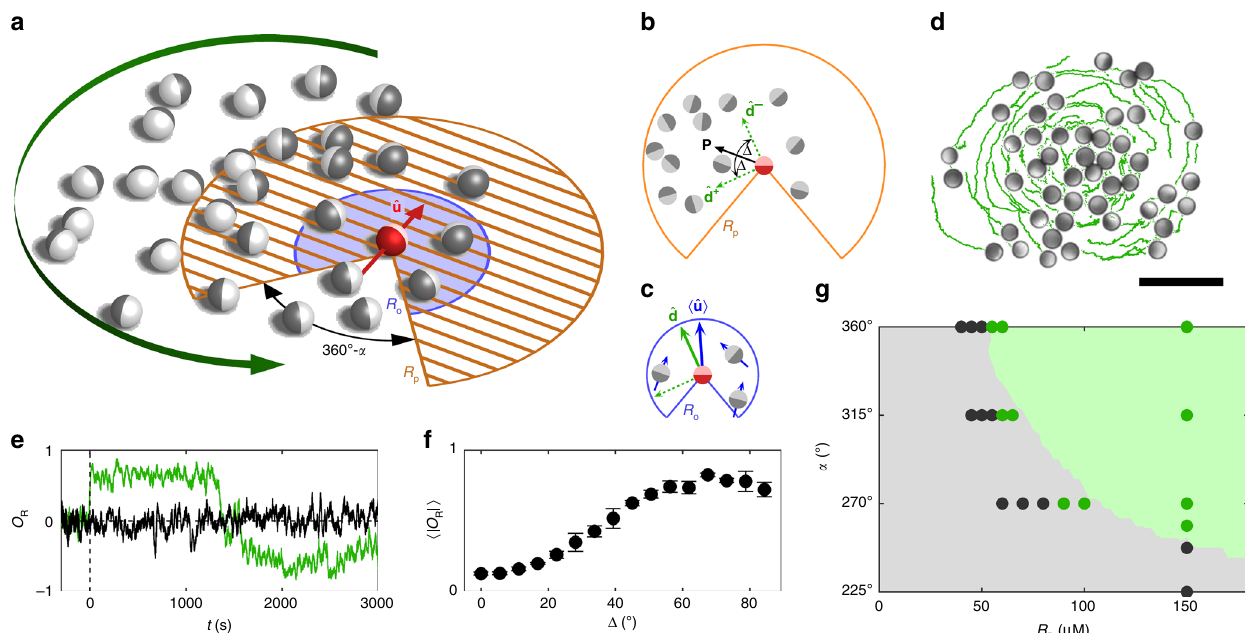
Fig. 1 Swirl formation of socially interacting active particles. a Illustration of interaction rule leading to circular group motion. An AP (red) senses the positions and orientations of neighbours within its fi eld of vision with angle α and range R p (orange dashed region and b ) and R o (blue region and c ), respectively. b After having determined the direction P to the centre of mass of sensed particles within distance R p , the AP selects one of two possible þ (cid:3) swimming directions ^ d or ^ d (green arrows) that deviate by the angle Δ to the left or the right relative to P . c The selection of the swimming direction ^ d depends on which of the two possibilities is closer to the mean orientation ^ u h i of neighbours being closer than R o . d Experimental snapshot of a counterclockwise rotating swirl for α = 360°, Δ = 67.5° and R p = ∞ . The solid lines show trajectories of 150 s. Scale bar is 30 μ m. e Time evolution of the j jh i as a function of the deviation angle Δ . Error bars correspond to the rotational order parameter O R for Δ = 67.5° (green) and Δ = 0 (black). f O R standard deviation of different experiments. g Existence range of cohesive swirls (green) as a function of α and R p determined from experiments (symbols) and numerical simulations (coloured areas) for Δ =